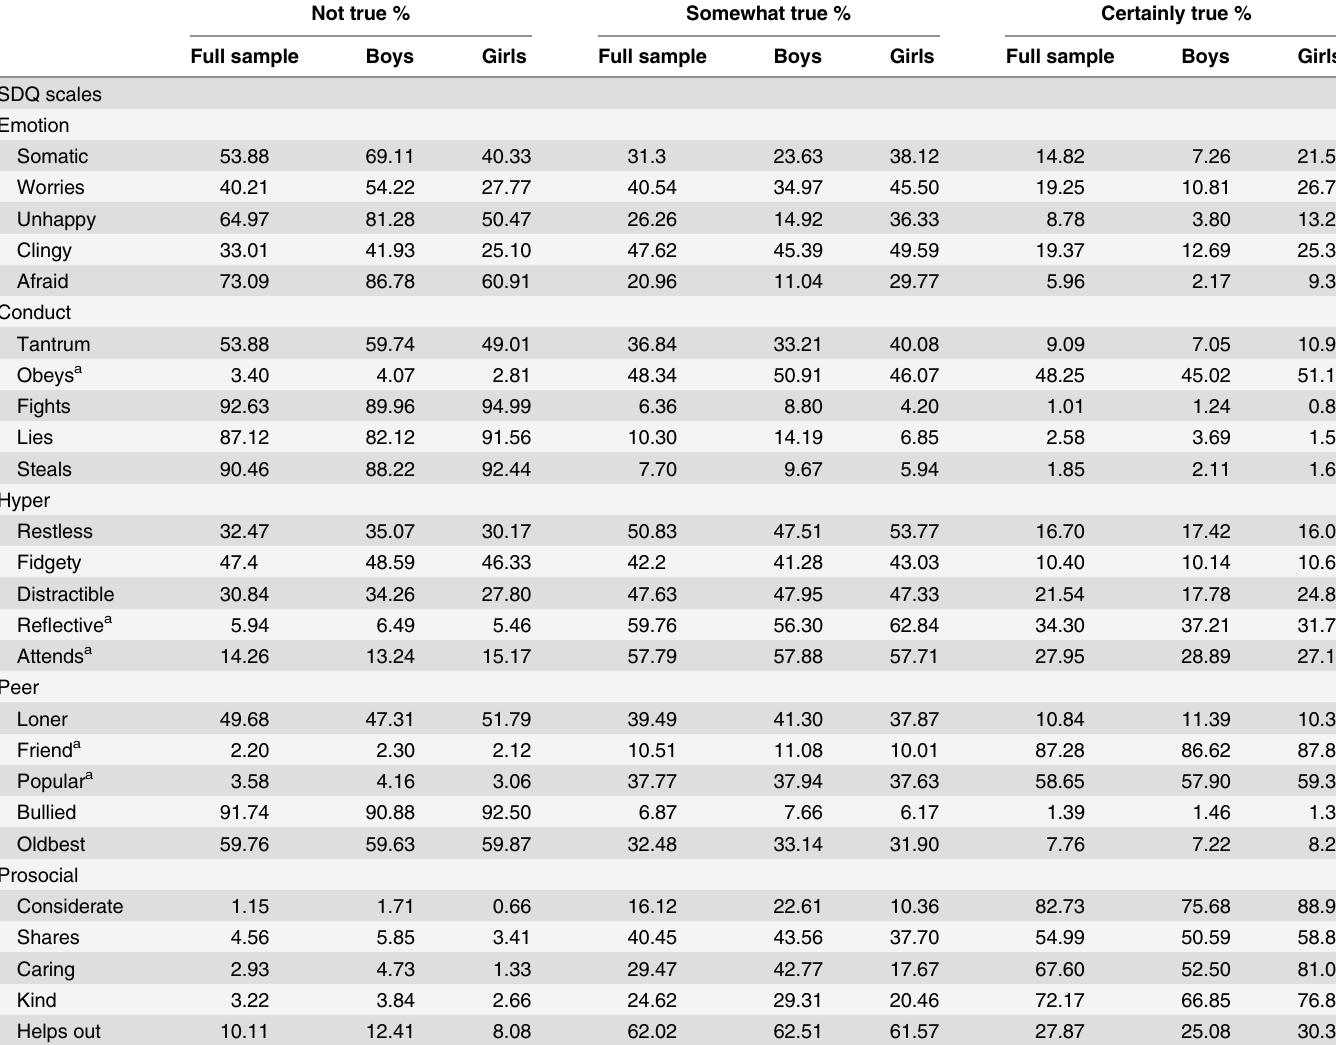
Table 1. Endorsement rates for response categories on each item in the Strengths and Difficulties Questionnaire for the full sample, and sepa- rately for boys and girls. Not true